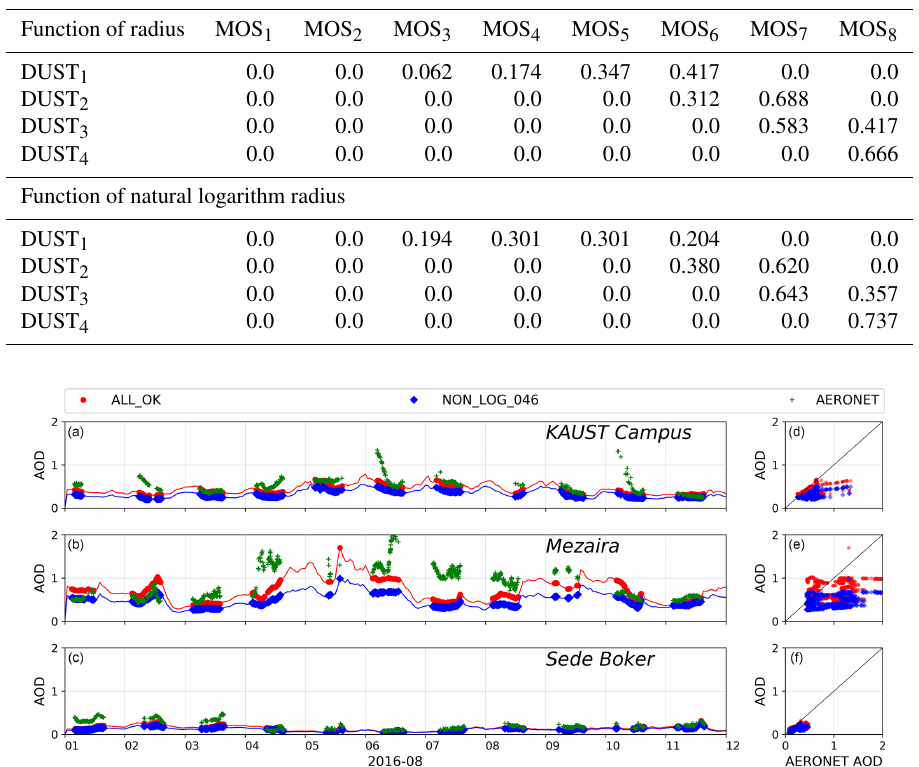
Table 5. Dust mass redistribution between GOCART and MOSAIC bins based on the assumption that bin concentration is a function of radius and on the assumption that bin concentration is a function of natural logarithm radius.